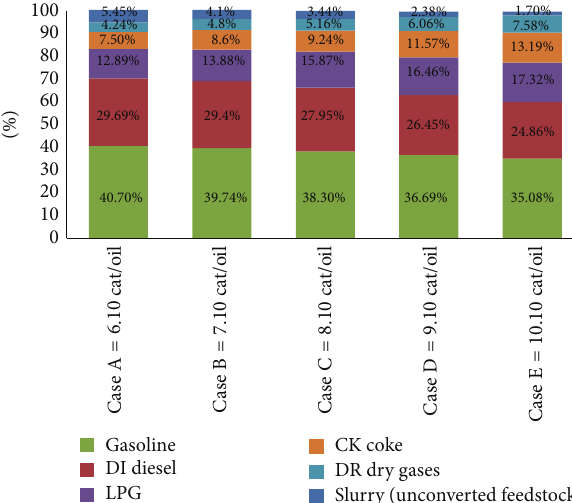
Figure 17: Temperature profiles for the axial plane with variations in catalyst-to-oil ratio.